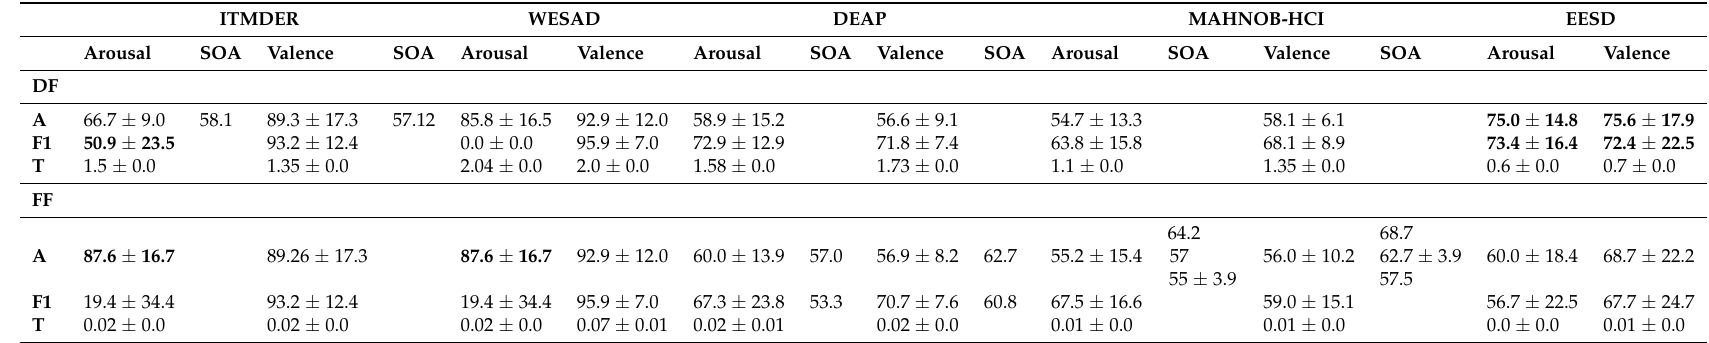
Table 6. Experimental results for the FF and DF methodologies in terms of Accuracy (A) and F1-score (F1), and time (T) in seconds, per dataset for the Arousal dimension in the FF methodology. Results obtained using LOSO. The SOA column contains the results found in the literature (ITMDER [7], DEAP [8], MAHNOB-HCI [53]). The best results are shown in bold.